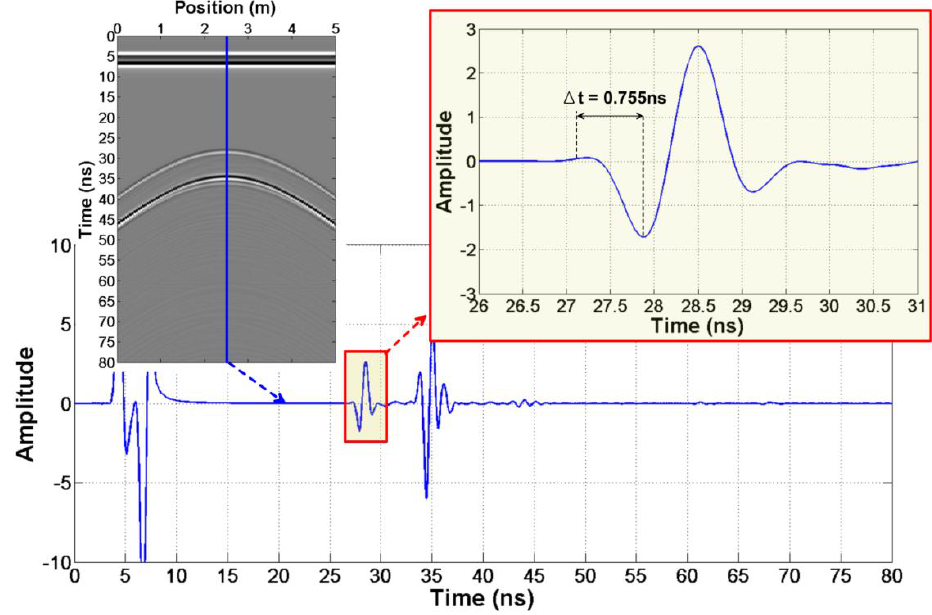
Figure 4. The reflection wavelet waveform of the abnormal body in the first case.